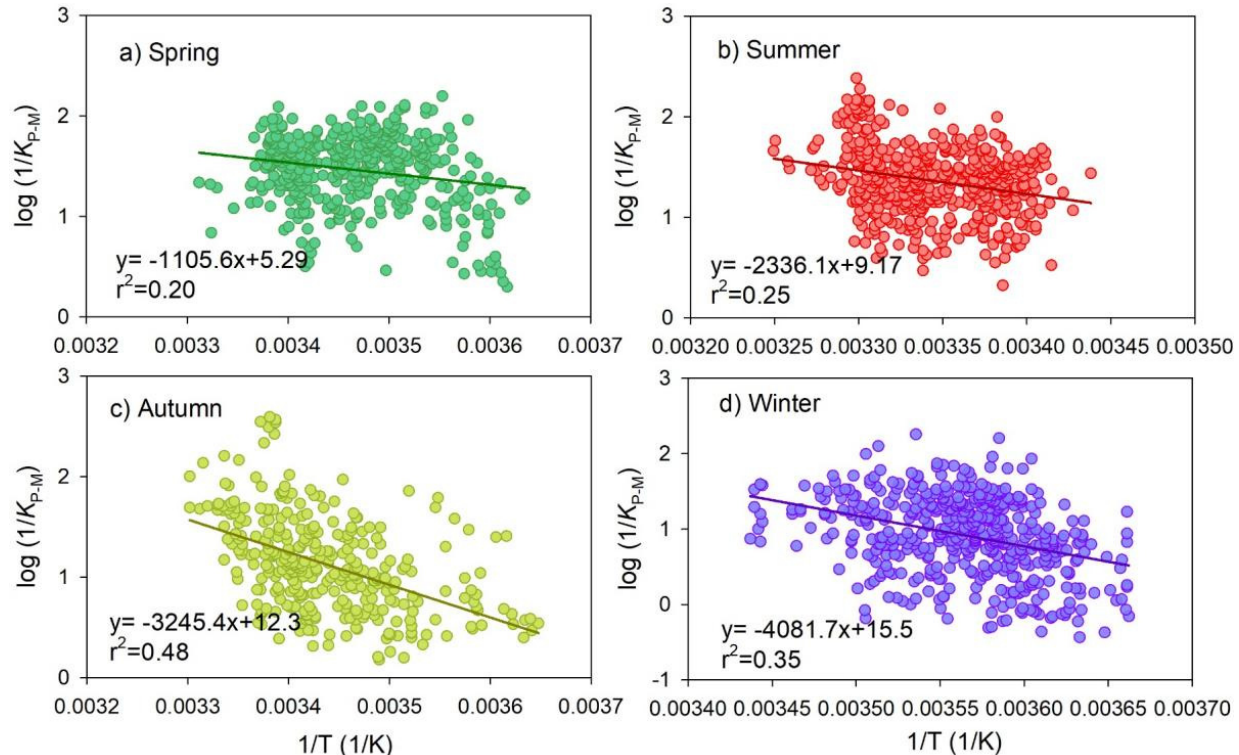
Figure 2. The relationship of measured log K P-M with 1/T in different seasons.